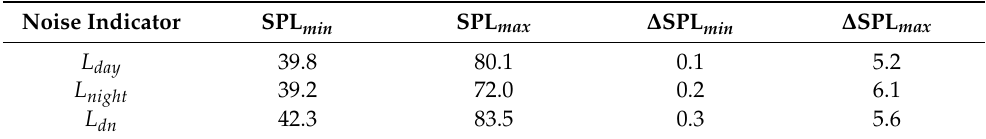
Table 4. Minimum ( min ) and maximum ( max ) noise levels of Panyu District in Guangzhou City with the existence of noise barriers. ∆ SPL = SPL wo − SPL w , where wo and w stand for without and with noise barriers, respectively. All units are in dBA. SPL min SPL max